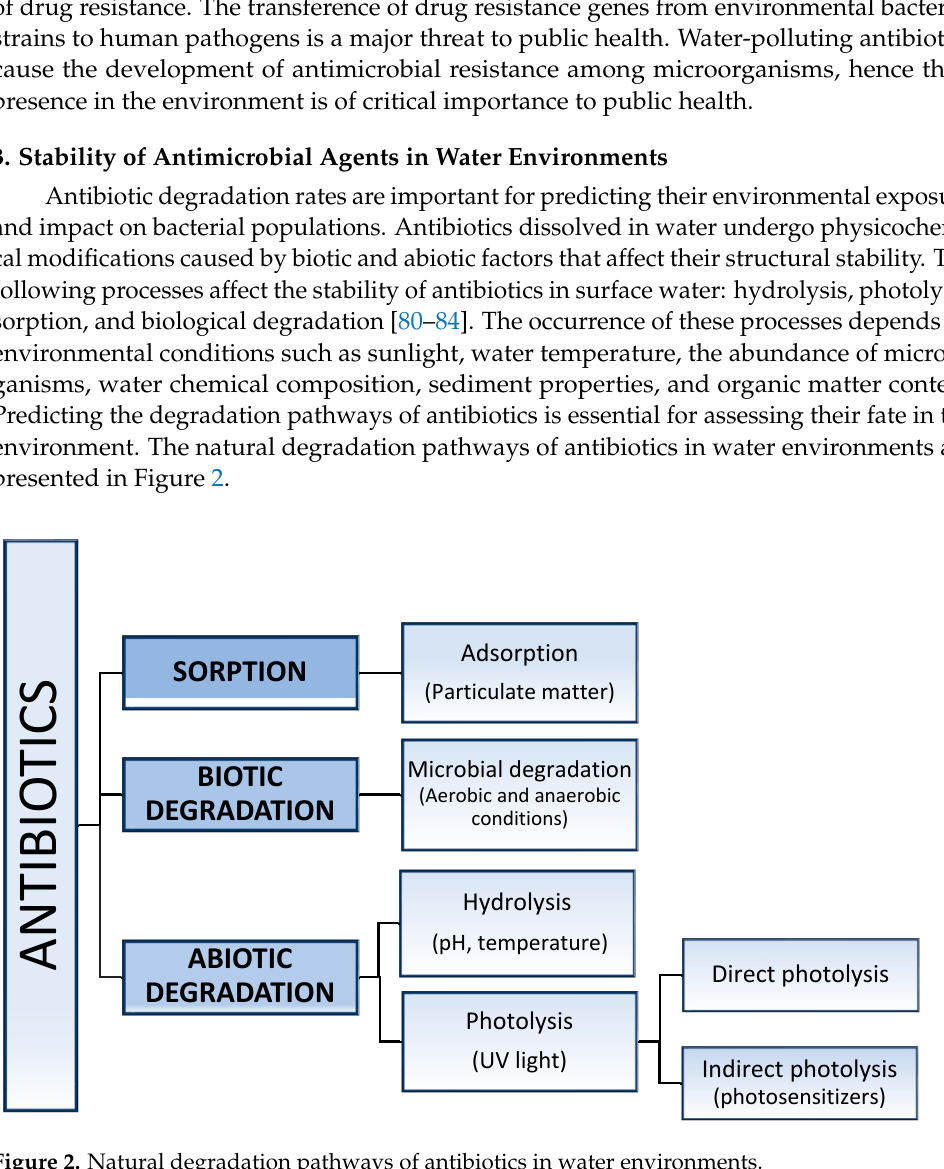
Figure 2. Natural degradation pathways of antibiotics in water